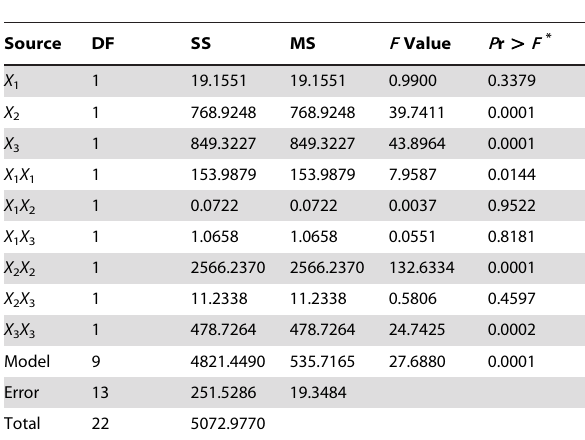
Table 3. Analysis of variance (ANOVA) for the fitted quadratic polynomial model for chlorpyrifos